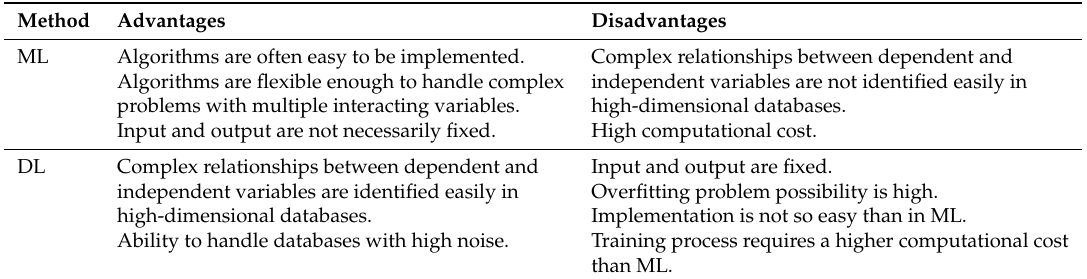
Table 3. Advantages and disadvantages of Machine Learning (ML) and Deep Learning